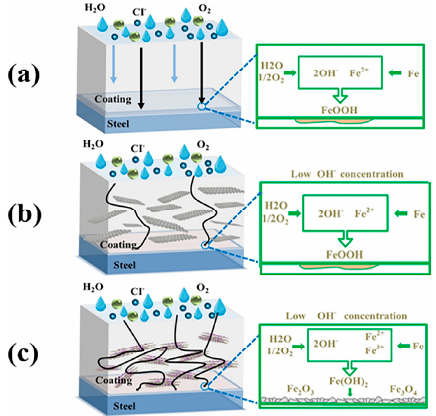
Figure 4. The protective mechanism of GO-PPy (polypyrrole) in anticorrosive formulations (Reprinted with permission from ref. [86] 2020 Elsevier).